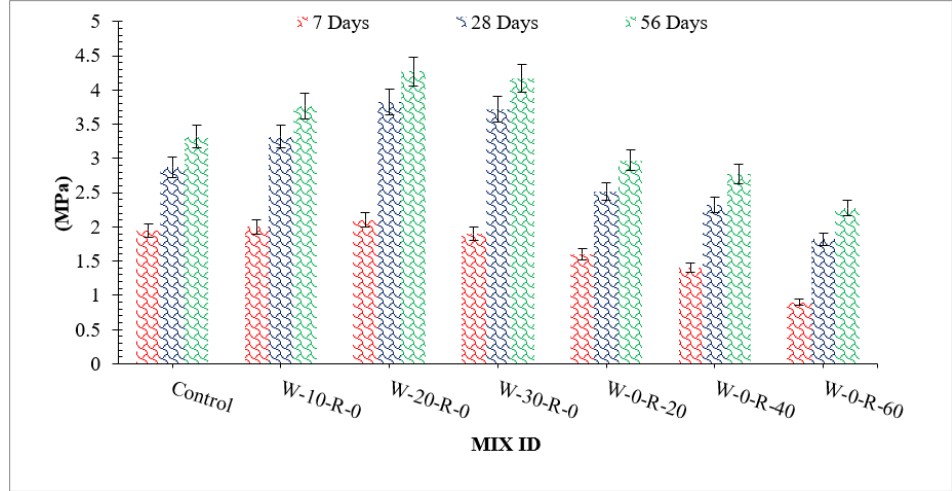
Figure 9. Split tensile strength.